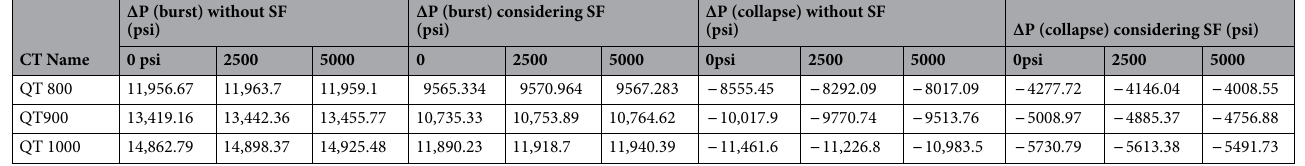
Table 7. ΔP with or without a safety factor for burst and collapse pressure.